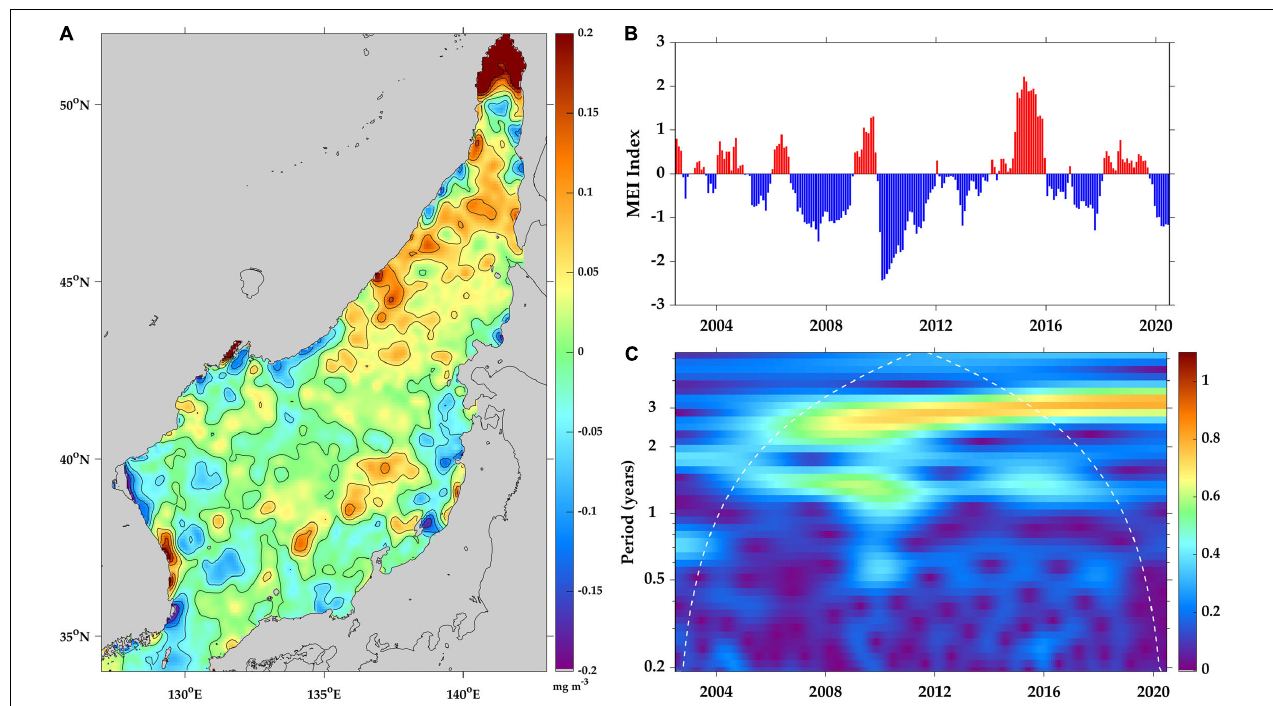
FIGURE 15 | Spatial distribution of (A) the responses of MODIS chlorophyll- a concentration variations to the ENSO index in the East Sea (Japan Sea) for 2003–2020, (B) ENSO index time series, and (C) wavelet of the ENSO index variations.